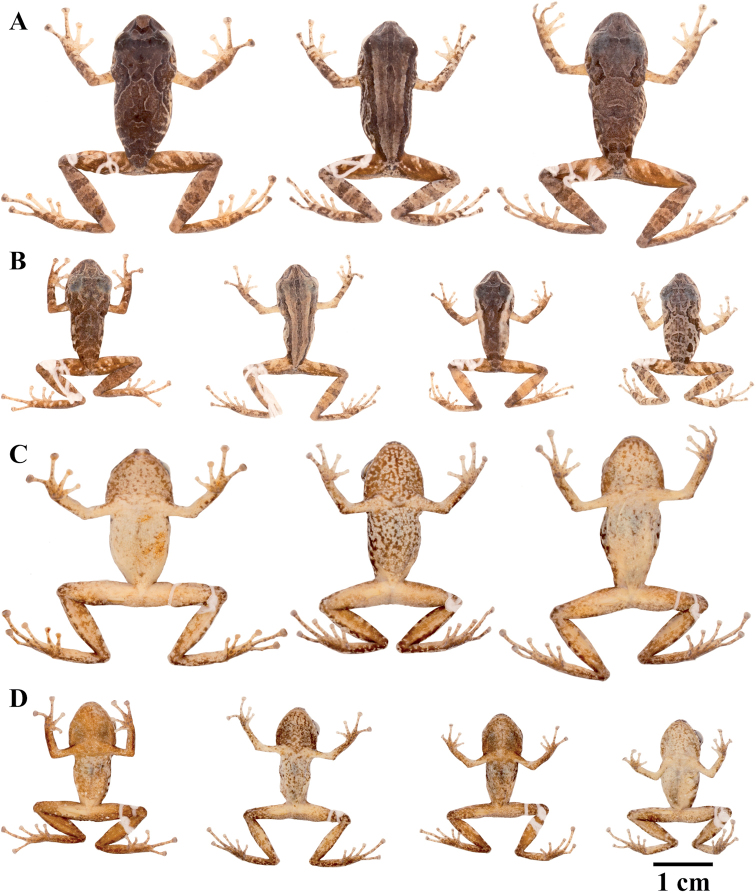
Color variation in preserved individuals of Pristimantis
nangaritza sp. nov. A Dorsal view of (from left to right): QCAZ 41730 (juvenile female), QCAZ 41735 (female), QCAZ 41736 (female) B Dorsal view of: QCAZ 41708 (male), QCAZ 41732 (male), QCAZ 41728 (male), QCAZ 41725 (male) C Ventral view of specimens in (A) D Ventral view of specimens in B. See Suppl. material 2 for locality data. All specimens are shown at the same scale.